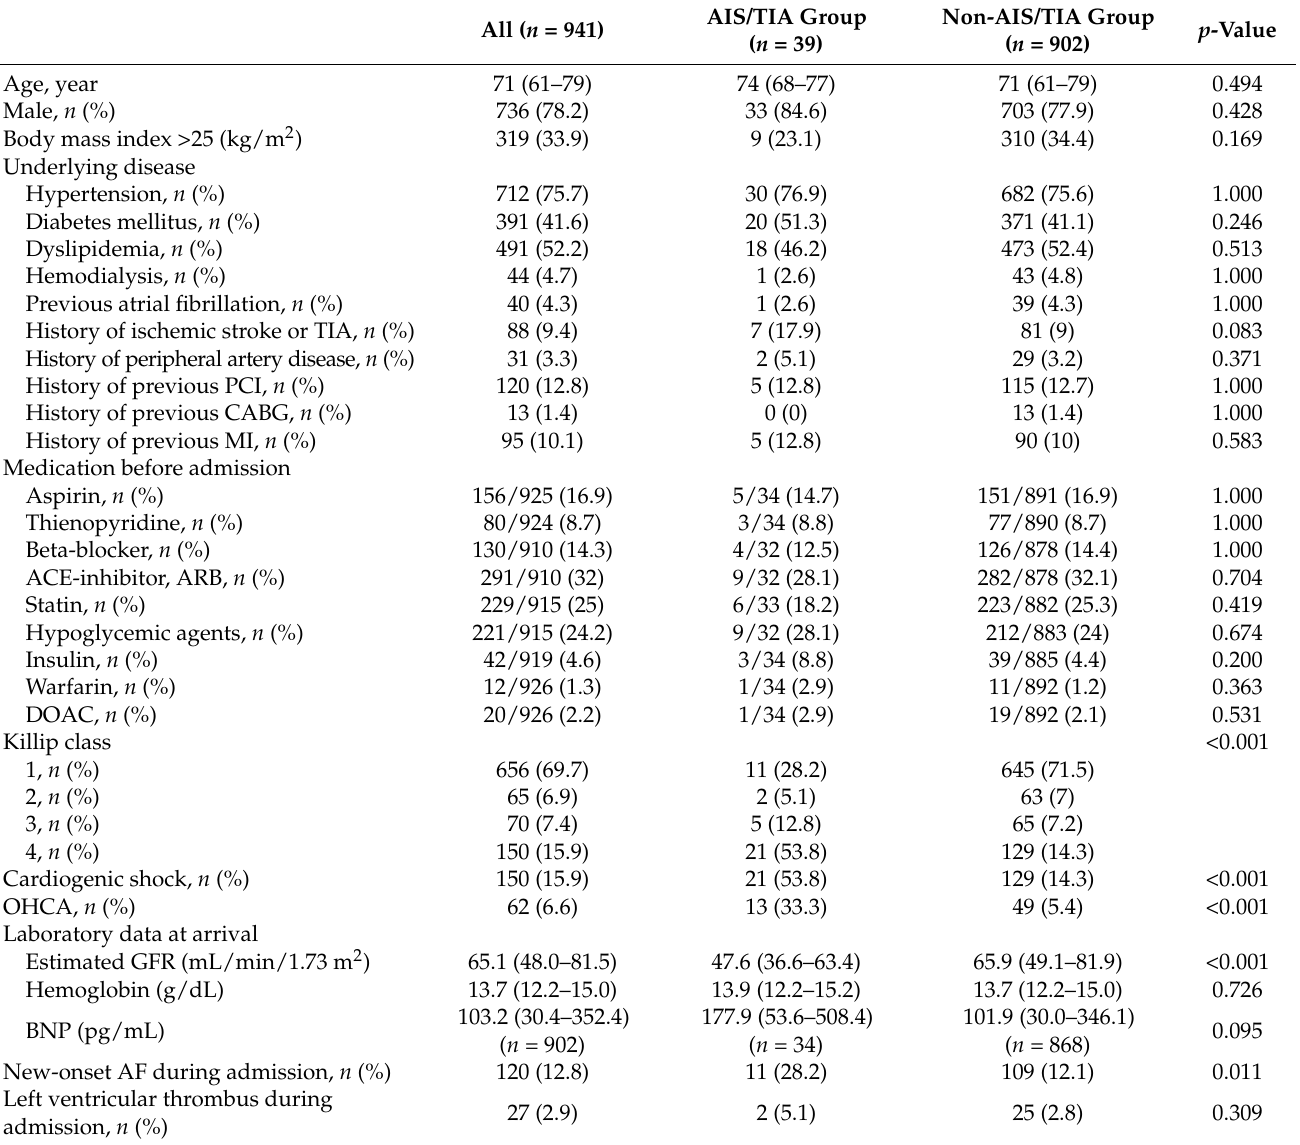
Table 1. Comparison of clinical characteristics between the AIS/TIA group and the non-AIS/TIA